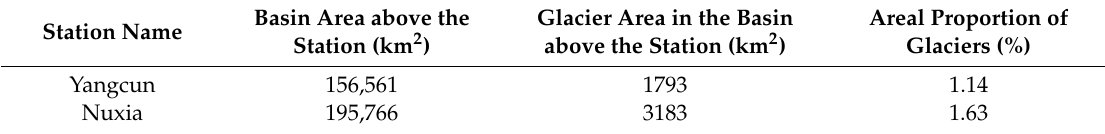
Table 1. The area and relative proportion of glaciers in the basins upstream of Nuxia and Yangcun hydrological stations.